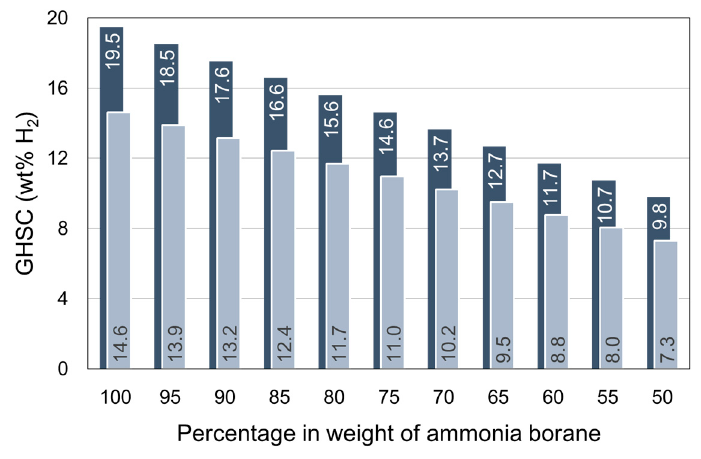
Figure 14. Gravimetric hydrogen storage capacity (GHSC) of ammonia borane (100 to 50% weight) mixed with a chemical dopant (0 to 50% in weight). With respect to the bars with no border, the capacity is based on 100% on the hydrogens of ammonia borane. For the bars with the white borders, it is assumed that 75% of the hydrogen of ammonia borane can be released. The capacities (in wt% H 2 ) are all given.